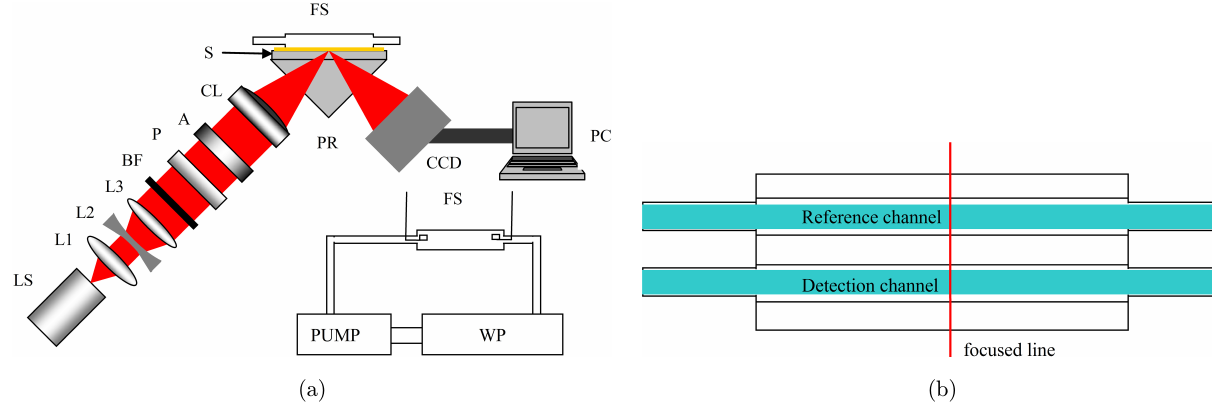
Fig. 1. (a) Schematic of experimental system combined with the temperature stabilization: LS, light source; L1, L3, convex lens; L2, concave lens; BF, bandpass ¯lter; P, linear glass polarizer; A, rectangular aperture; CL, cylindrical lens; PR, prism; S, SPR chip; FS, °uidic system; CCD, charge coupled device; PC, personal computer. Inset: Schematic representation of temperature control system; WP, water bath; PUMP, peristaltic pump. (b) Schematic of dual channel °uidic